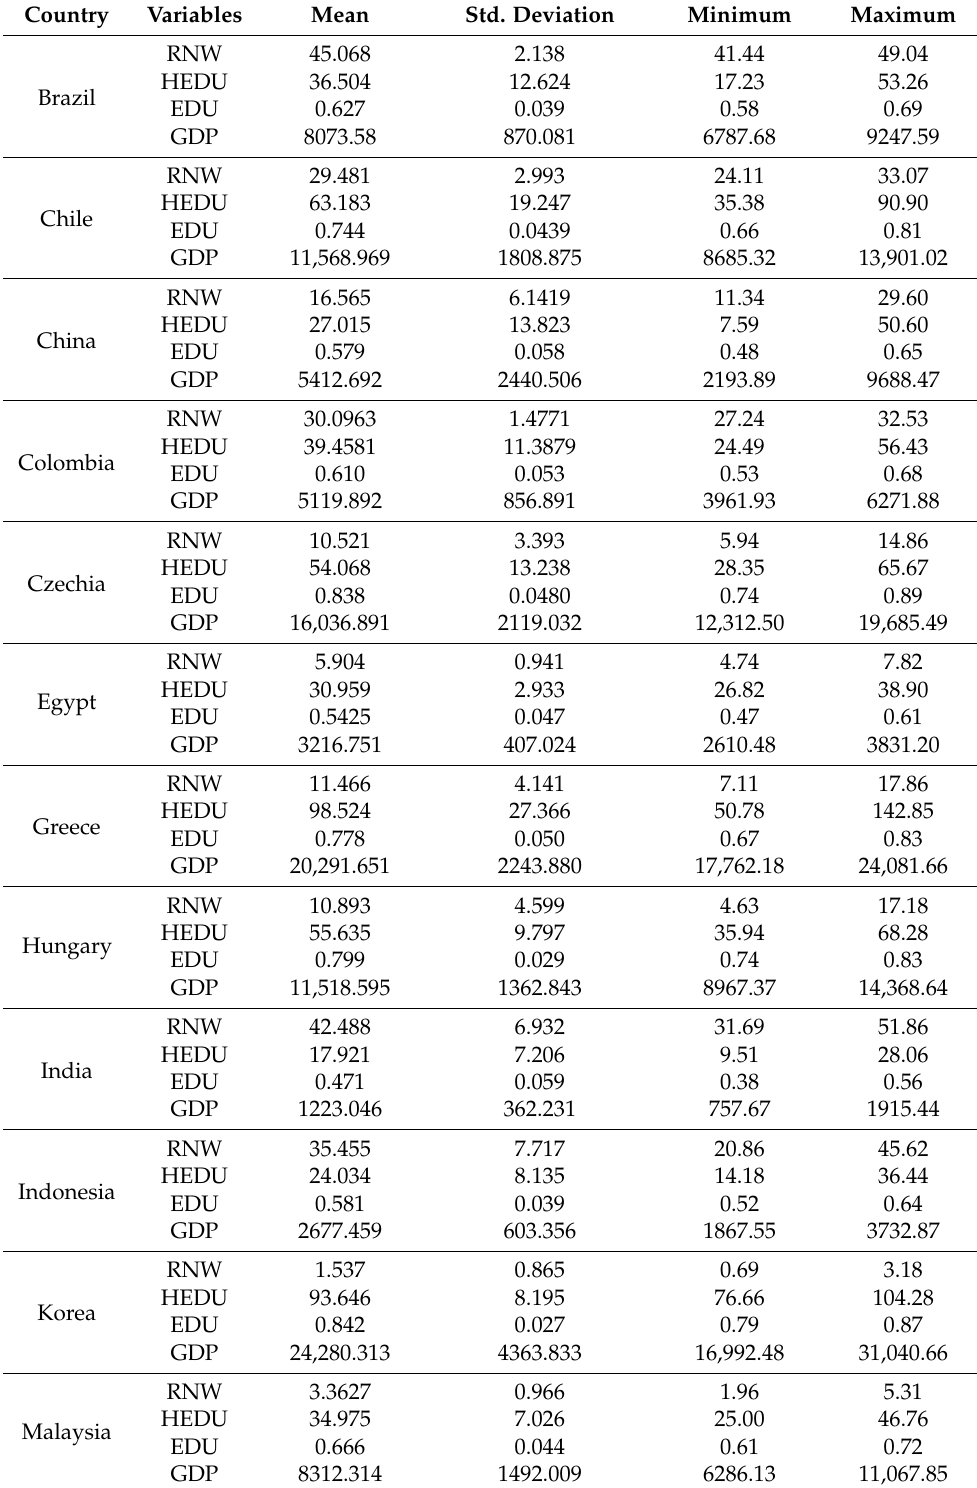
Table A1. Country summary